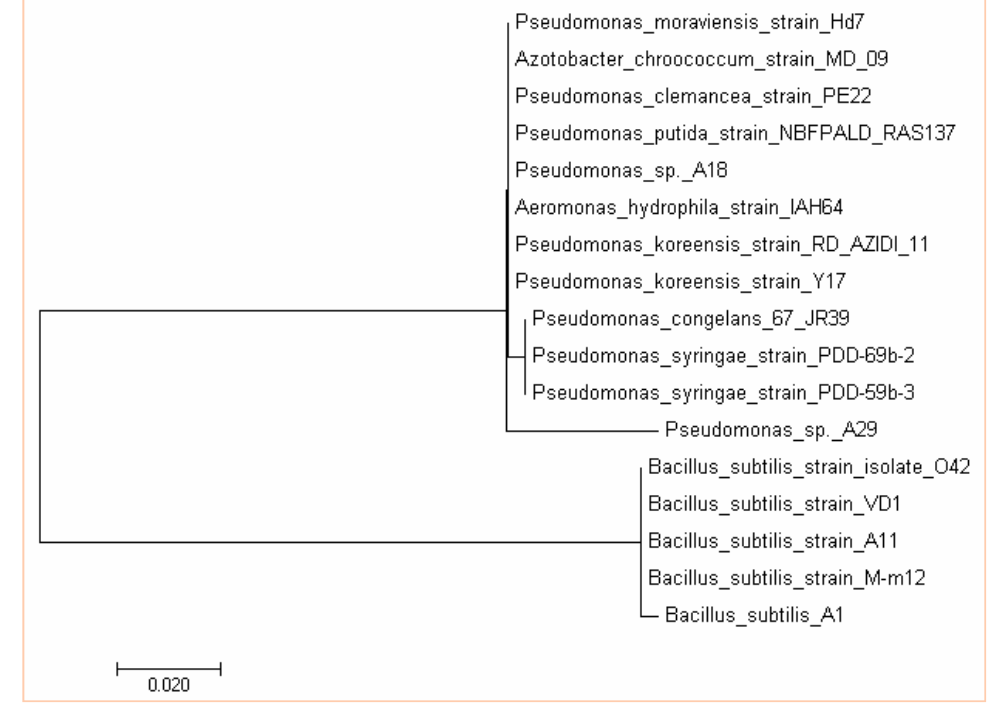
Figure 4. Evolutionary relationships of taxa of Bacillus subtilis and Pseudomonas sp. The evolutionary history was inferred using the maximum parsimony method. The bootstrap consensus tree inferred from 1000 replicates is taken to represent the evolutionary history of the taxa analyzed. The evolutionary analysis was conducted in MEGA7.